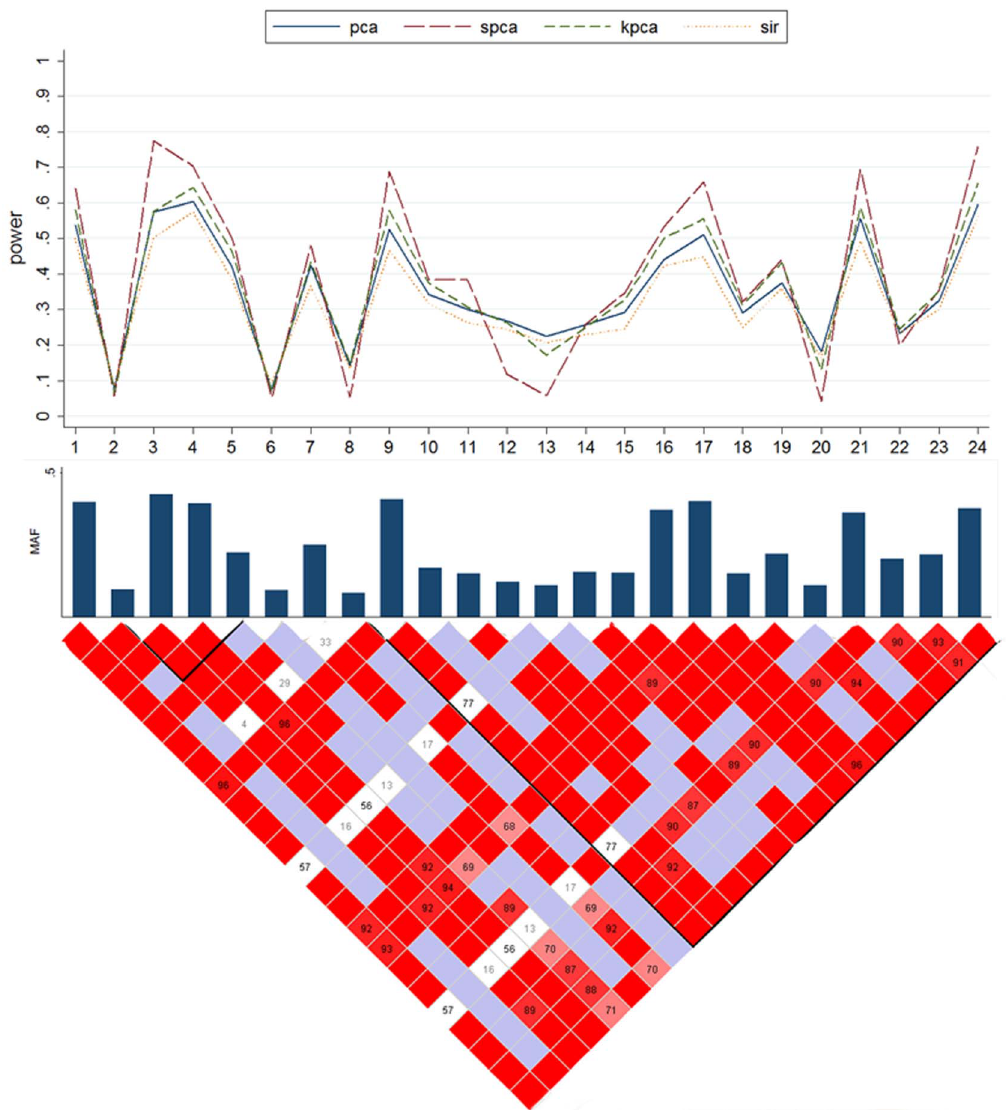
Figure 4. Powers of the causal SNP in Scenario C2 based on the XRCC1 gene. The top plot shows the power (y-axis) of each method over the locations (x-axis) of the causal SNPs. The bar-plot shows the MAFs of all SNPs. The LD structure of the 24 SNPs is shown by the heat plot in the bottom of the figure, in which the red scale indicates the value of R 2 (1=red, 0=white).